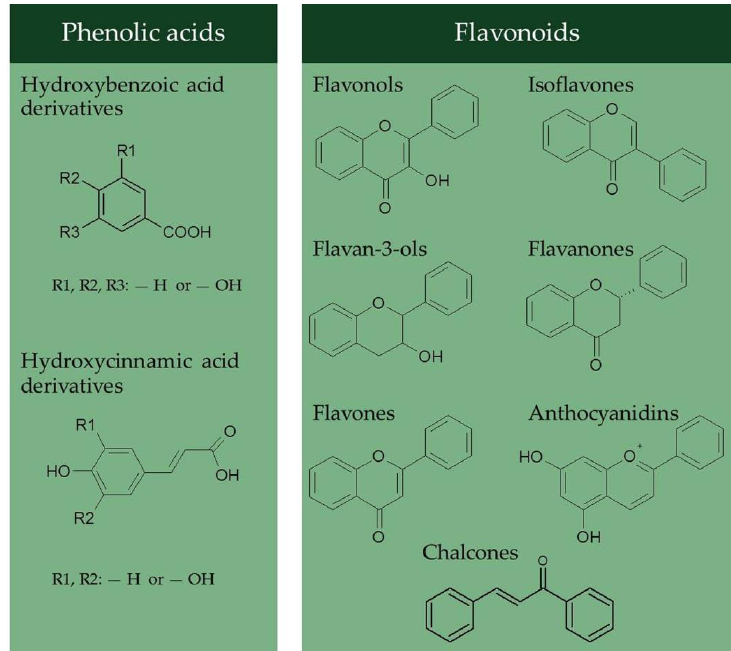
Figure 1. Chemical structure of the main dietary phenolic